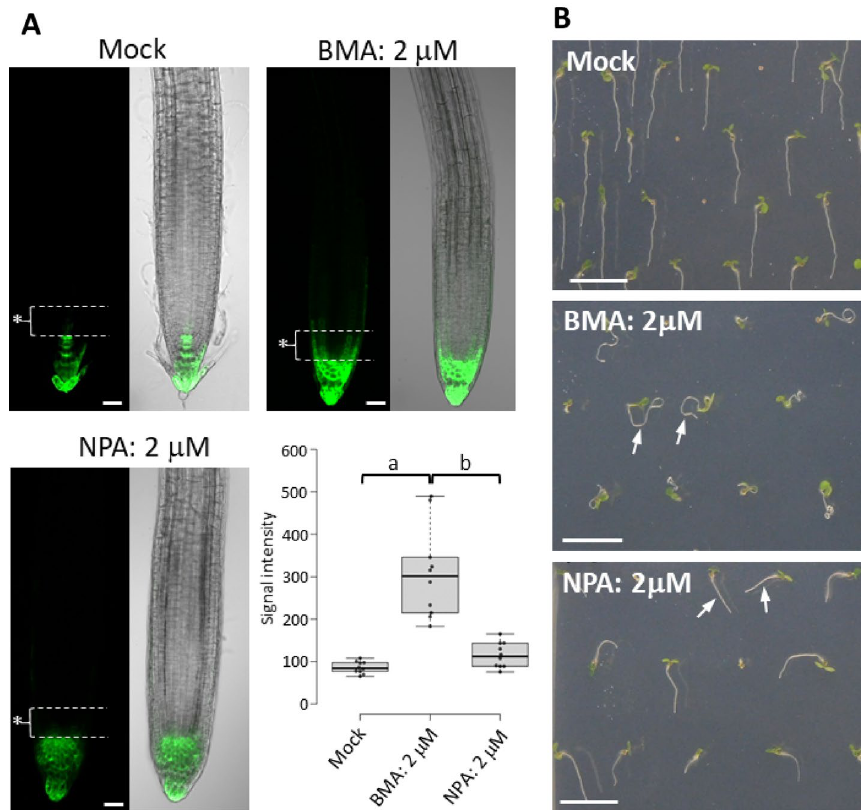
Figure 6. ( A ) Effect of BMA, and NPA, on DR5:GFP expression in Arabidopsis root tips. Arabidopsis DR5:GFP transgenic line was grown on a vertical agar plate containing 2 μM of BMA and NPA for 6 days under contentious light conditions. GFP signals of the seedlings were observed using LSCM Olympus FV-1000. Bar = 30 μm. Fluorescence signal intensity in the ROI (Asterisks; region 50 μm from QC) were compared. (a) and (b) indicate significant difference between data (Tukey, p < 0.01). n = 10. ( B ) Comparison of the effects of BMA and NPA on the growth of Arabidopsis seedlings. Arabidopsis was grown on a vertical agar plate containing 2 μM of BMA and NPA for six days under contentious light conditions. Arabidopsis roots are elongated in a curve in the presence of BMA (arrows in the BMA image), whereas roots are elongated linearly in the presence of NPA (arrows in the NPA image). Bar = 1